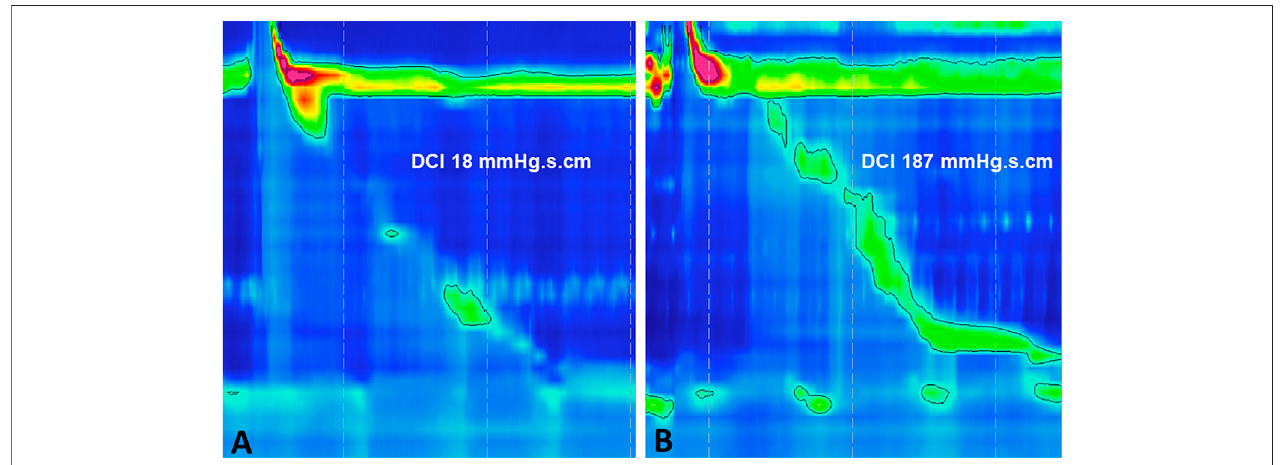
FIGURE 1 | Esophageal high-resolution manometry demonstratingIneffective Esophageal Motility (IEM) (A) failed peristalsis(DCI < 100 mmHg scm) and (B) weak peristalsis (DCI 100 – 450 mmHg s cm). IEM, ineffective esophageal motility; DCI, distal contractile integral.